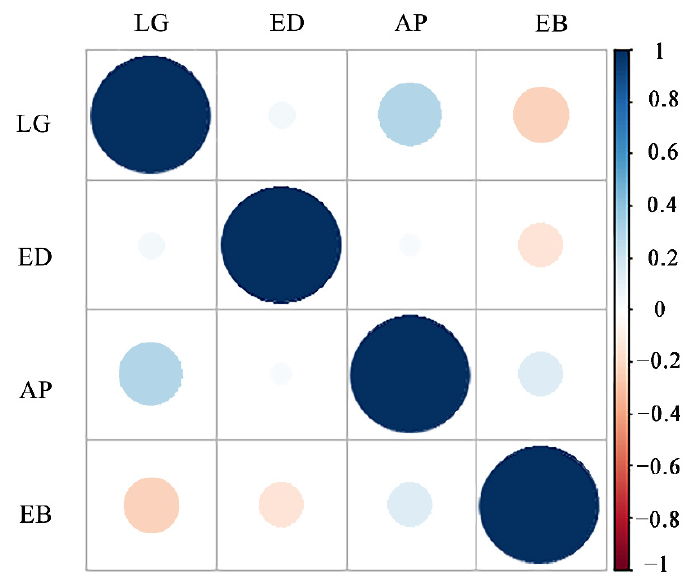
Figure 3. Correlations of multiple rural functions in Yongchang County.